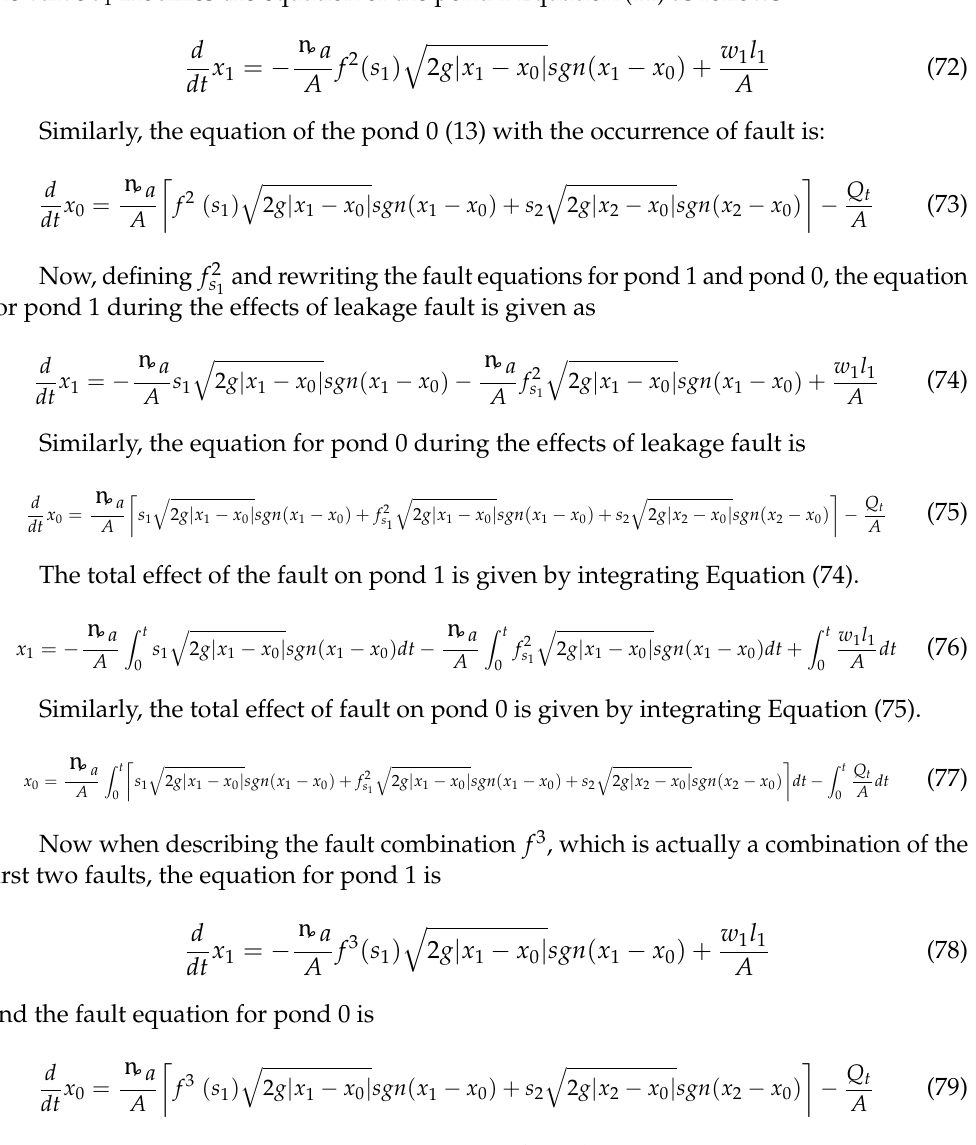
Figure 1. Three-pond hydraulic system.